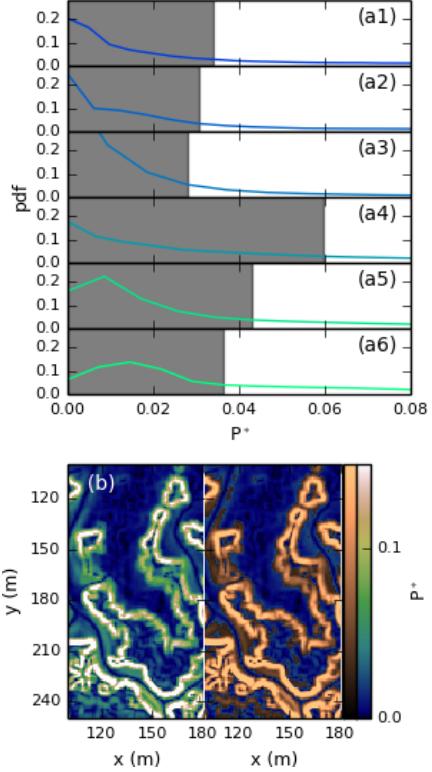
Figure 3. (a1–6) Frequency distribution of P ∗ for sites S1–6. The greyed portion of the plot represents pixels that are not included in the initial search space Ss ∗ ; (b) raster representation of P ∗ for site S1: Shell Bay. Values of P ∗ under P ∗ th use the topographic colour scheme, while values above P ∗ th use the copper colour scheme and are included in Ss ∗ .